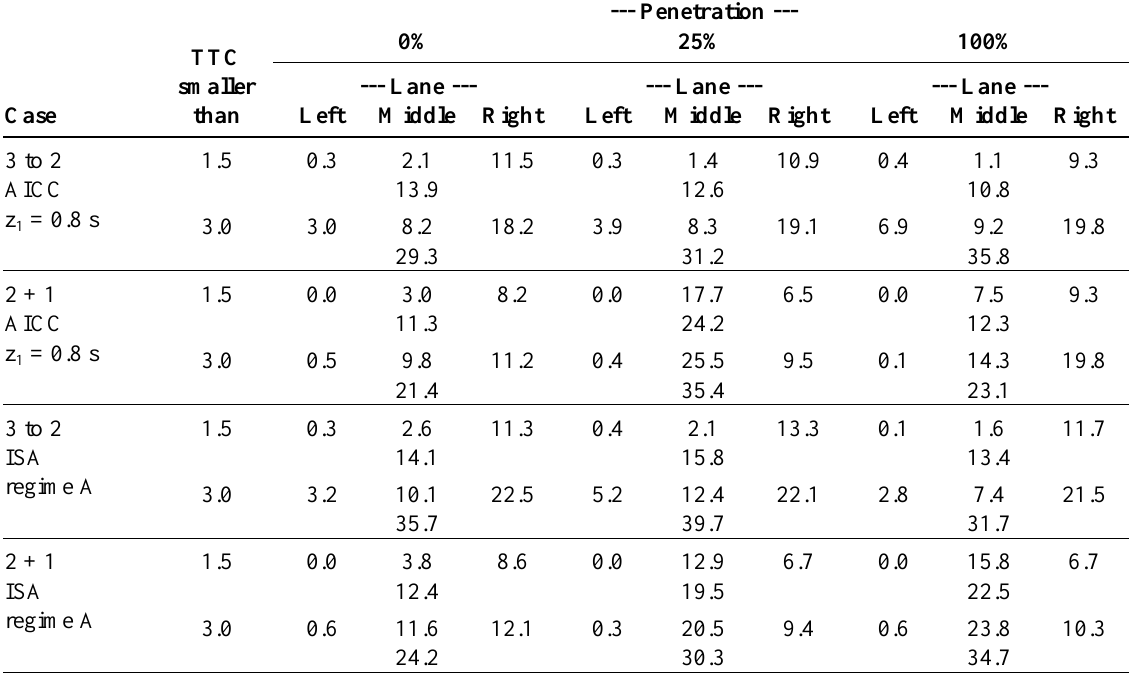
Table 3 Impacts of ADAS on TTC distribution for different scenarios. The figures indicate the Time Exposure Time-to-collision (in seconds), i.e. the total time drivers experience safety-critical or uncomfortable TTC’s (for the left, middle, or right lane, or all lanes